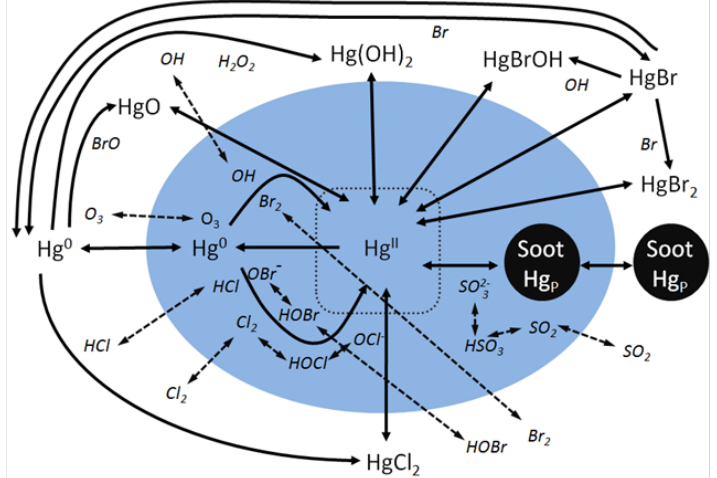
Figure 3. The chemical model for mercury implemented in Polyphemus. Gaseous and aqueous Hg phases are marked by white and blue, respectively. The line arrows show possible transformations of mercury, and the dashed arrows show additional species used in the model that react with